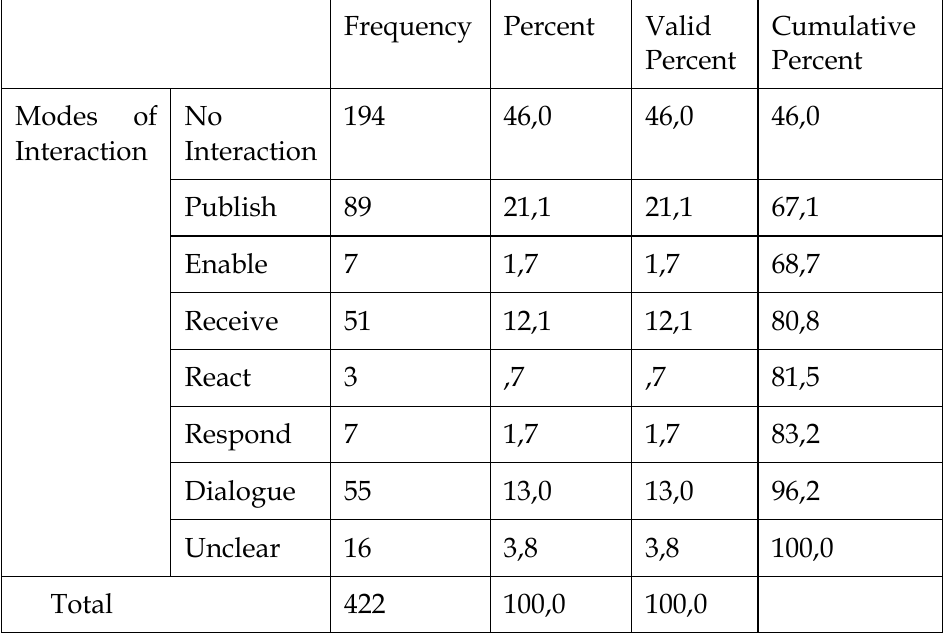
Frequency Percent Valid Percent